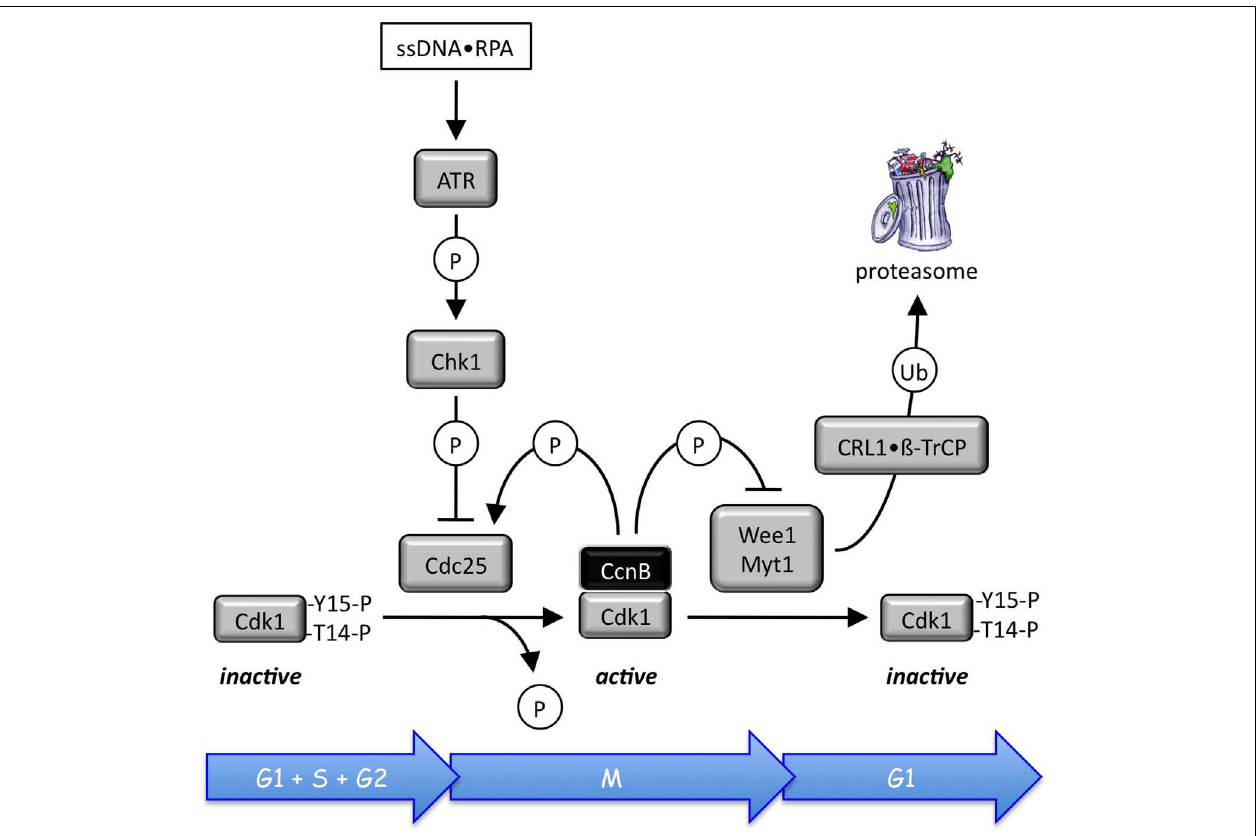
is phosphorylated by Cdk1 • CcnB, facilitating its degradation by the ubiquitin ligases CRL1 • β TrCP and CRL1 • Tome1. Conversely, Cdc25 is activated by multiple CDK phosphorylations.This allows Cdk1 • CcnB to convert graded inputs into switch-like, irreversible responses once a critical portion of the enzyme becomes active. In mammalian cells, all three Cdc25 isoforms have been implicated in cell cycle regulation. Cdc25A regulates both G 1 /S and S/G 2 transitions, while Cdc25B and Cdc25C regulate late G 2 and mitosis, respectively (Lavecchia et al.,